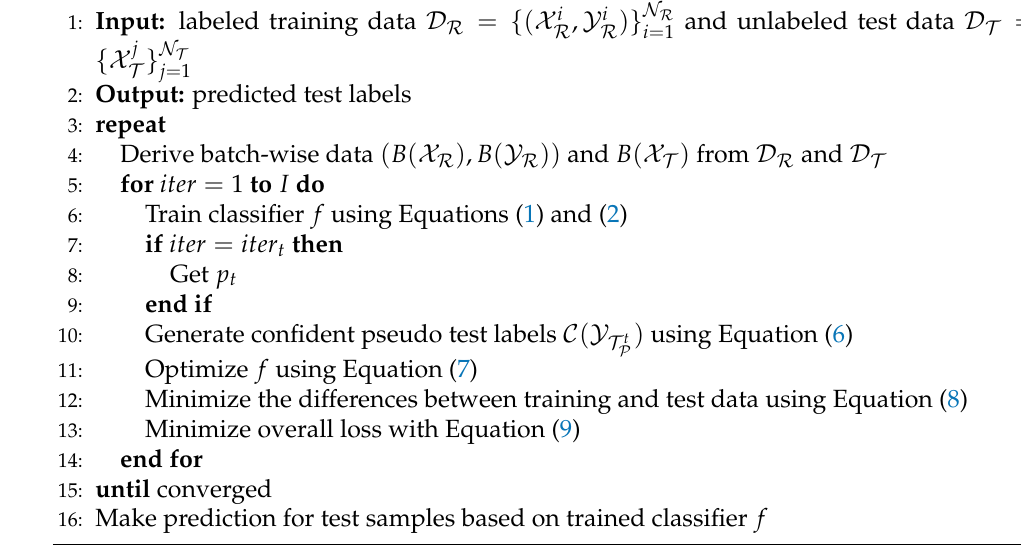
Algorithm 1 Separable Confident Transductive Learning Network. B ( · ) denotes the mini- batch sets, I is the number of iterations. p T = { p t } T learning. iter t is the t -th adjustment learning.